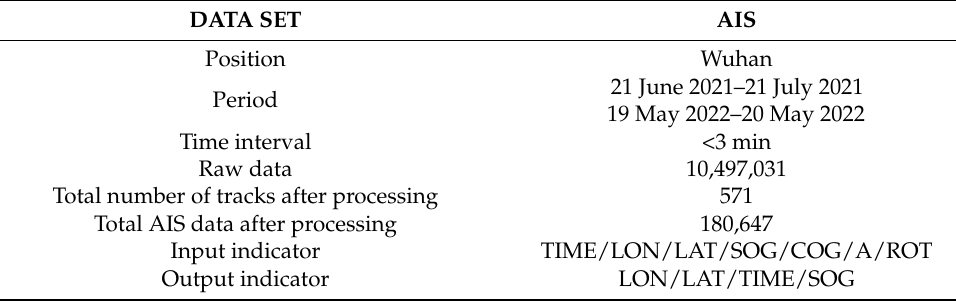
Figure 2. MMSI = 413802216 sending time chart. The amount of data before and after processing is shown in Table 1. Table 1. Experimental use data table .